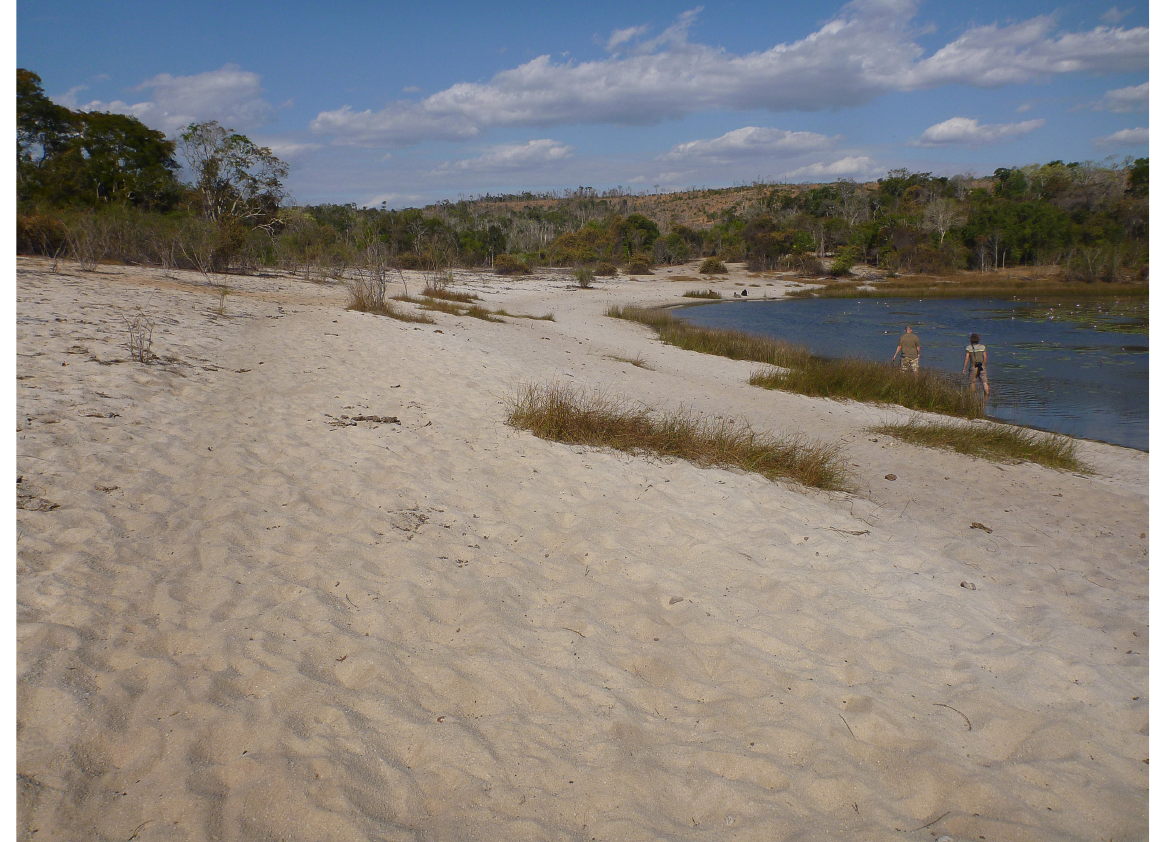
Fig. 2. Habitat on type locality of Ocyale ghost Jocque M. & Jocqué R. sp. nov. (photo by MJ, July